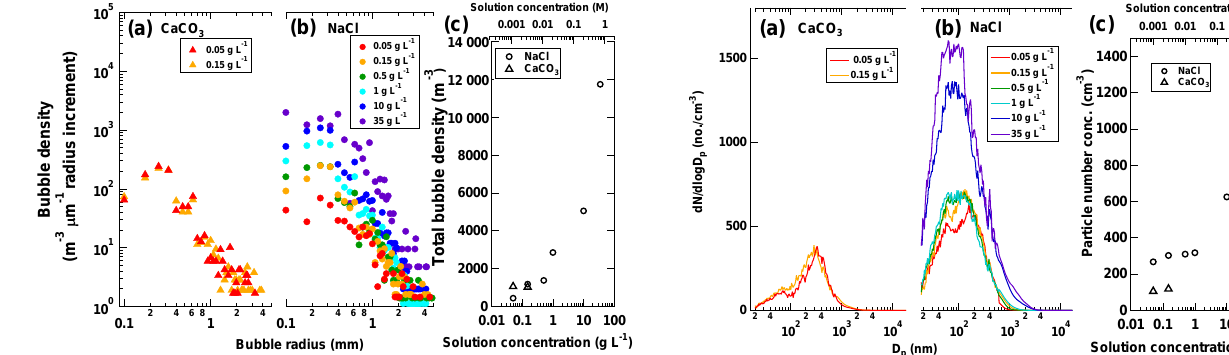
Figure 8. Average aerosol number concentration generated by the LSA generator as a function of solution concentration for (a) CaCO 3 and (b) NaCl, as well as (c) total aerosol number con- centration as a function of ion composition for CaCO 3 and